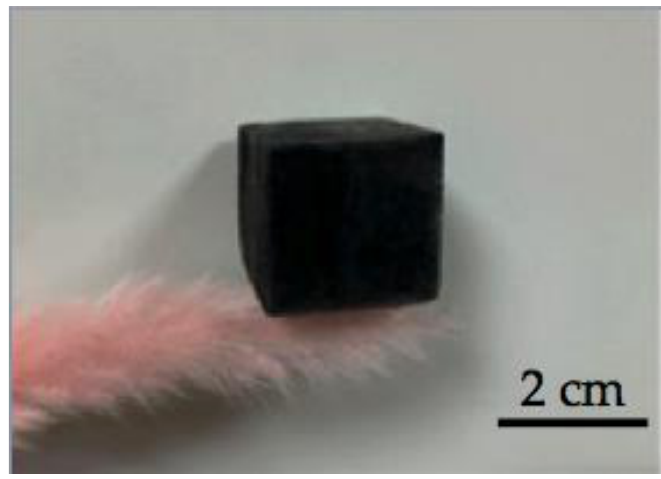
Figure 3. The photo of the M – rGO – ascorb composite placed on a tinted feather. The obtained materials represent a series of eight sorption experiments: melamine (without pretreatment); melamine treated with different rGOs, with GO reduction reagents